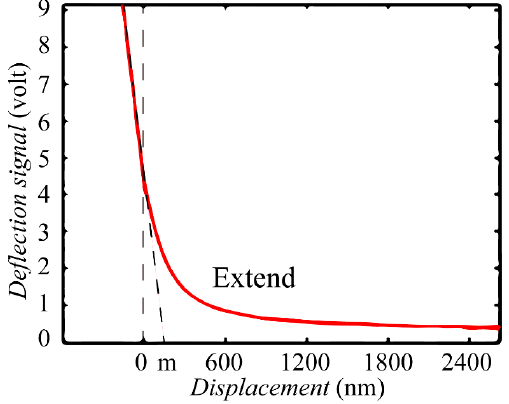
Figure 7. Process curve after removing virtual deflection.